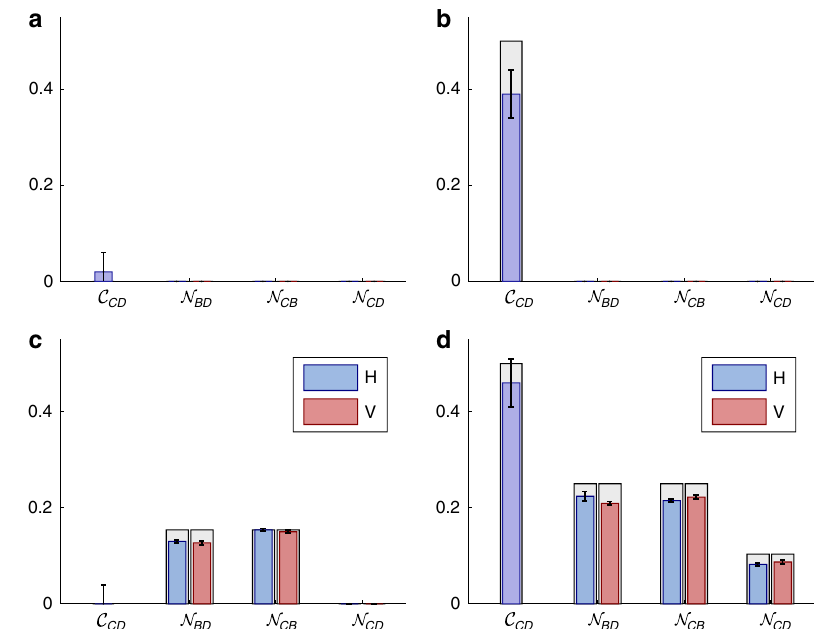
Figure 7 | Classifying causal relations using induced correlations. For each circuit in Fig. 4, we present theoretical (grey) and experimental (coloured) values for the different witnesses of causal relations. Circuits b , d have C CD 6¼ 0, witnessing physical mixtures, whereas a , c are consistent with probabilistic mixtures, since C CD is zero within 1 s.d. Circuits c , d show evidence of intrinsically quantum cause-effect and common-cause mechanisms, N c BD 6¼ 0 and N d CB 6¼ 0 for d , c ¼ H , V , whereas a , b are consistent with classical mechanisms. Only d has N b CD 6¼ 0 for b ¼ H , V , witnessing a quantum Berkson effect. Uncertainties indicate 1 s.d. and are estimated using Monte-Carlo simulations, assuming Poissonian noise on the photon